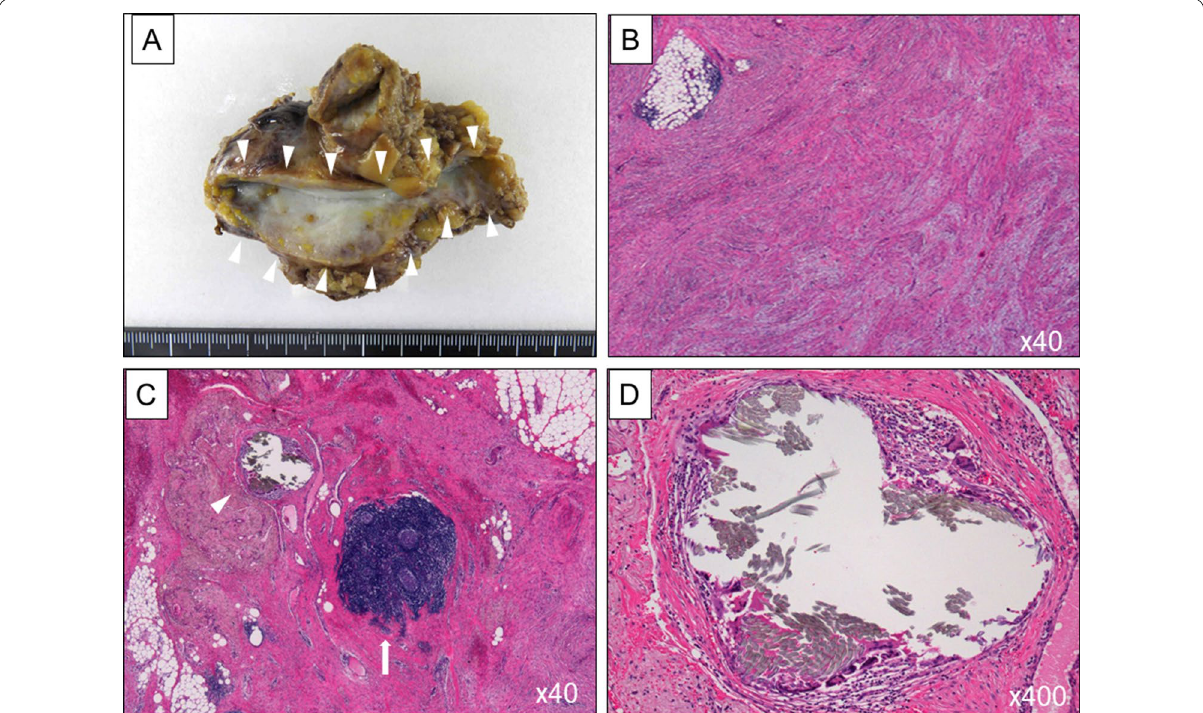
Fig. 3 Resected specimen and pathological examination. The resected specimens revealed a mass that had surrounded the right ureter ( A arrow). Pathological examination of the tumor revealed dense fibrous proliferation ( B ) and lymphatic follicles with germinal centers ( C arrow). In the partially resected tumor, sutures with foreign giant cells were found ( C arrowhead, D